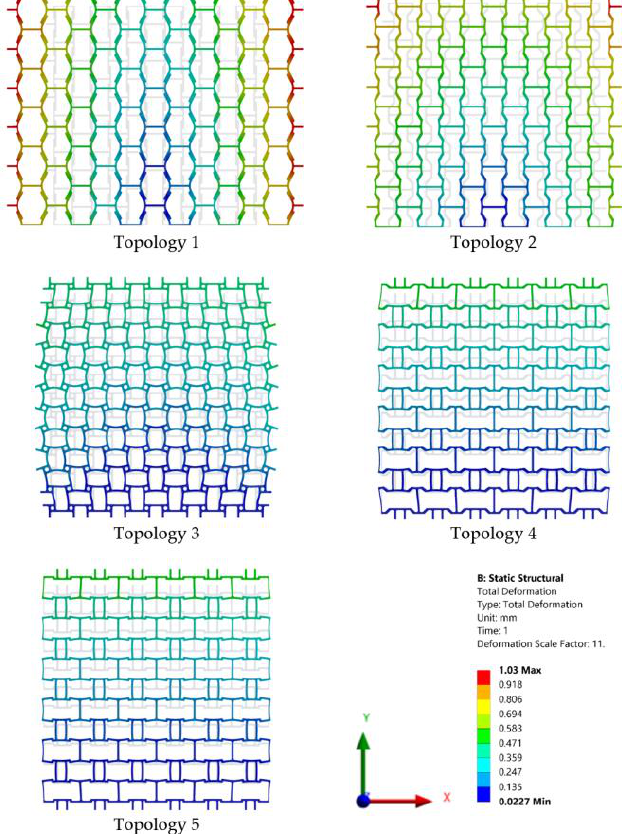
Table 3. Properties and results of the analysed topologies.